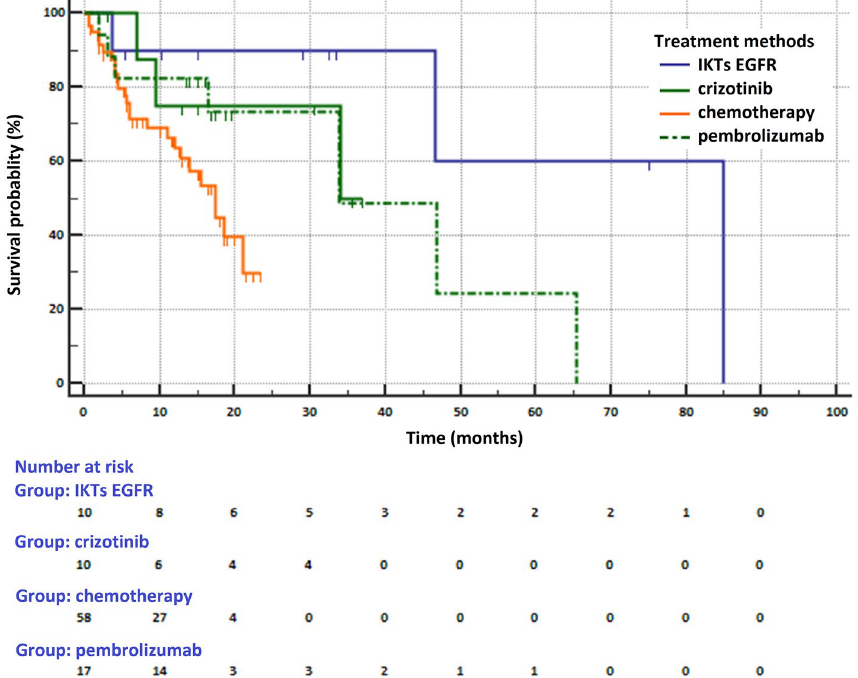
Figure 3. Survival of NSCLC patients treated with various methods (MedCalc Statistical Software version 18.11.6, https:// www. medca lc.